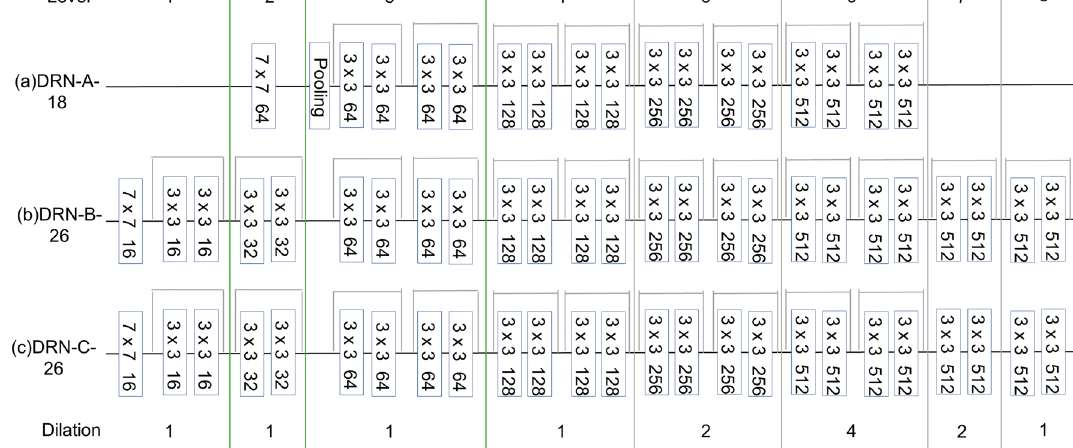
Figure 3. DRN network structure diagram.